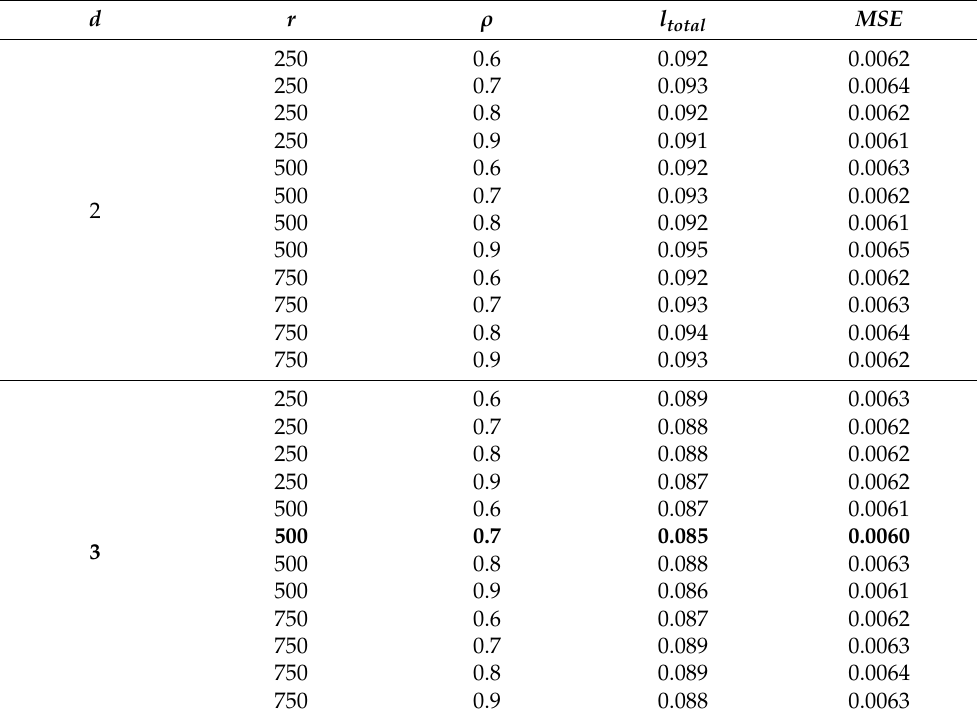
Figure 7. Spatial location of Western Buffer District and nearby monitoring points. Table 1. Prediction results with different parameters in Oxtail Sea. The bold numbers are the best